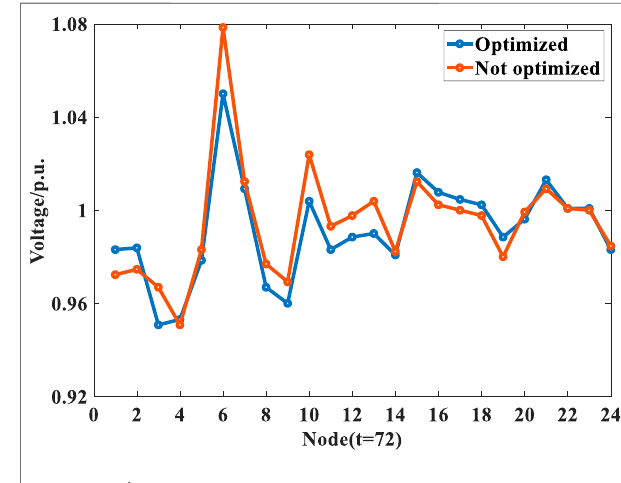
FIGURE 12 | Histograms of node voltage (p.u.) across the network with the random or optimized ESS placement in a particular day.